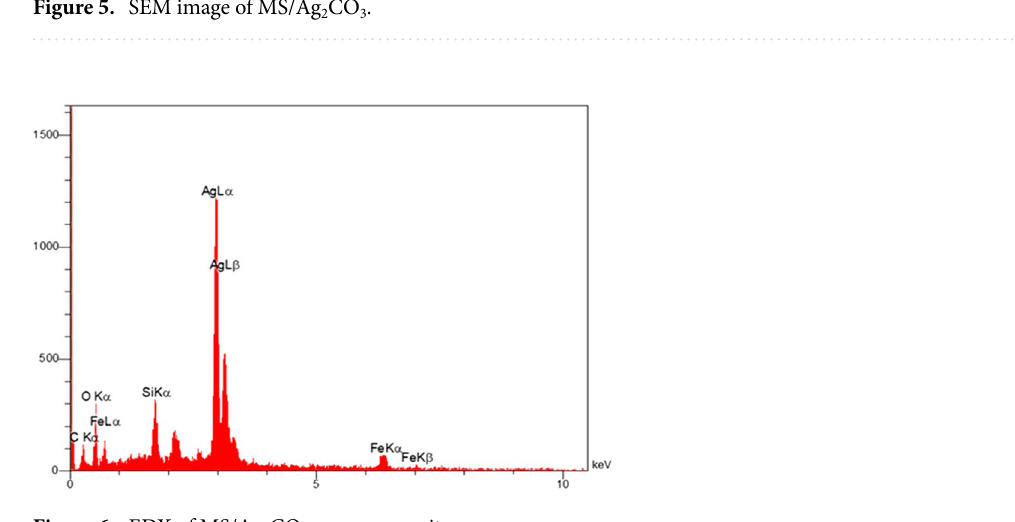
Figure 6. EDX of MS/Ag 2 CO 3